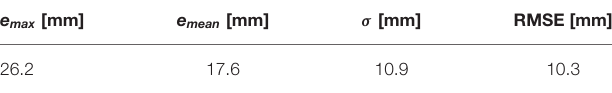
TABLE 2 | Experimental results.